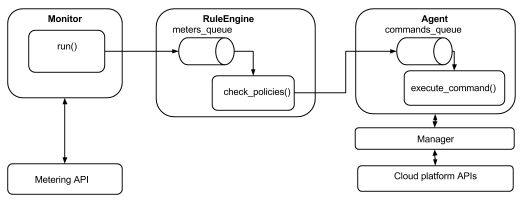
Figure 2: The CloudTUI-FTS